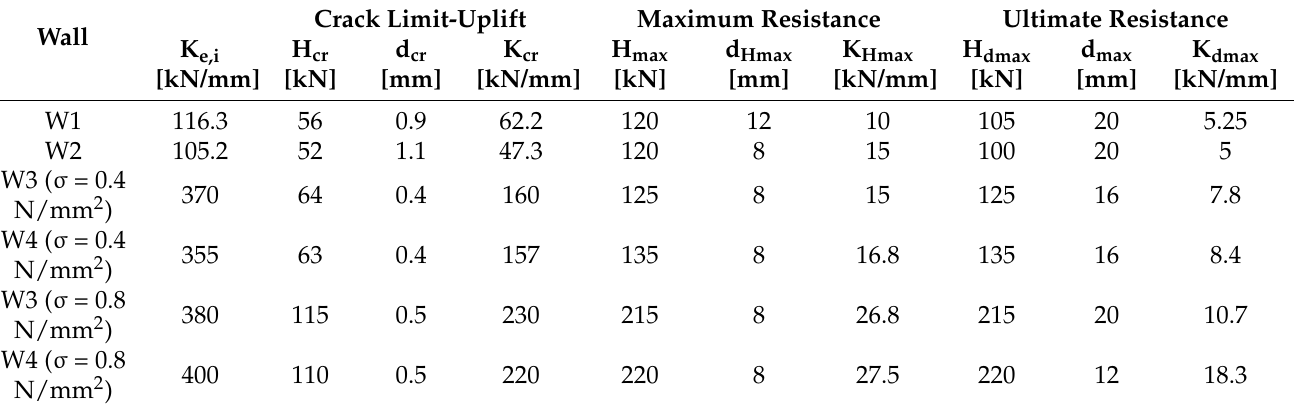
Figure 23. Comparison of hysteretic curves for W3 for different vertical compressive stress. Table 12. Comparison of resistance and deformability parameters for the tested